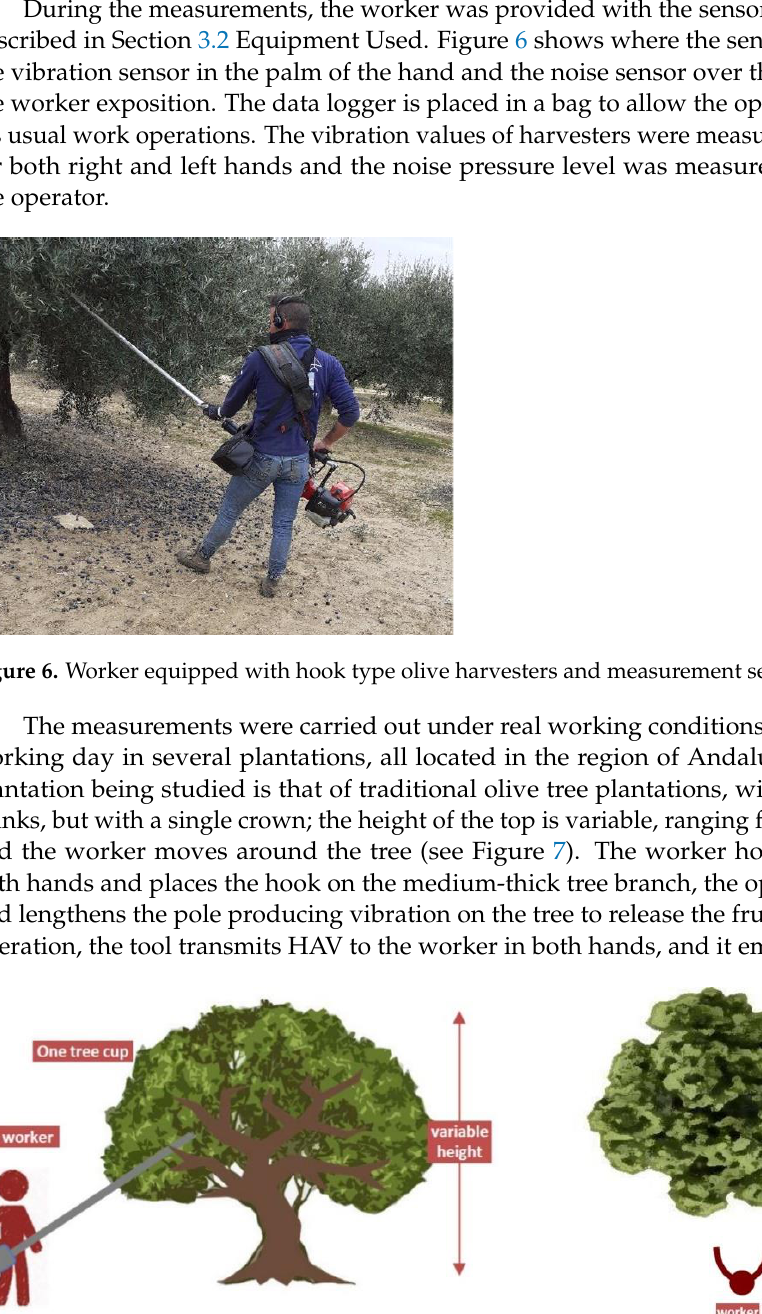
Table 2. Measured machine. Noise and vibration values declared by the manufacturer.